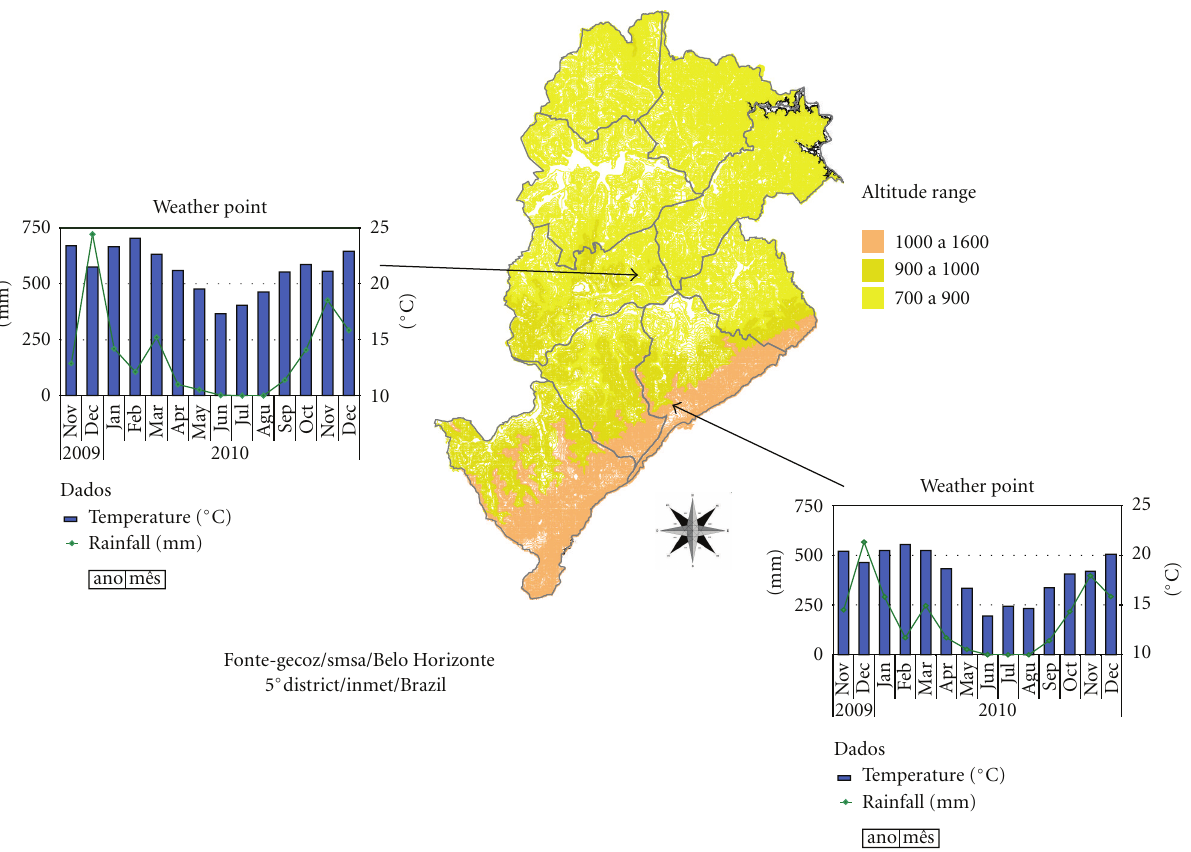
Figure 7: Monthly minimum temperature and rainfall, from Nov/2009 to Nov/2010, weathers geographic points, and altitude range, Belo Horizonte/MG, Brazil.